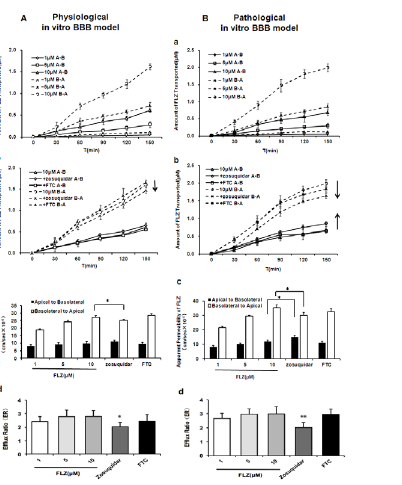
Figure 7. Membrane ATPase assays of P-gp and BCRP activity. Drug efflux transporter ATPase activity was examined in P-gp (A and B) and BCRP (D and E) membrane preparations following various concentrations of FLZ exposure and specific drug efflux transport inhibitors. 200 m M Verapamil was used as a positive control in P-gp ATPase assays. Only the P-gp membranes produced a clear concentra- tion dependent response to FLZ. Results are expressed as mean 6 SD (n=3). Inset in panel C shows the P-gp mediated ATPase activity examined in the presence of 10 m M FLZ and 5 m M zosuquidar (P-gp inhibitor) or/and 10 m M FTC (BCRP inhibitor). All data are expressed as the means 6 SD (n=3). * P , 0.05 , ** P , 0.01 , significantly different from FLZ